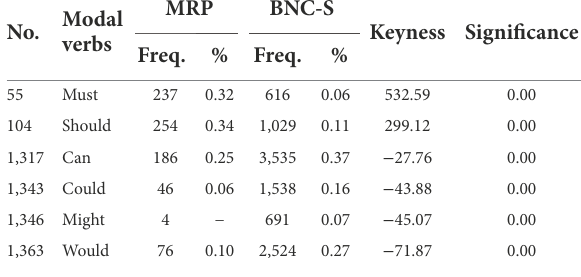
TABLE 17 Key modal verbs in MRP (in comparison with BNC-S).